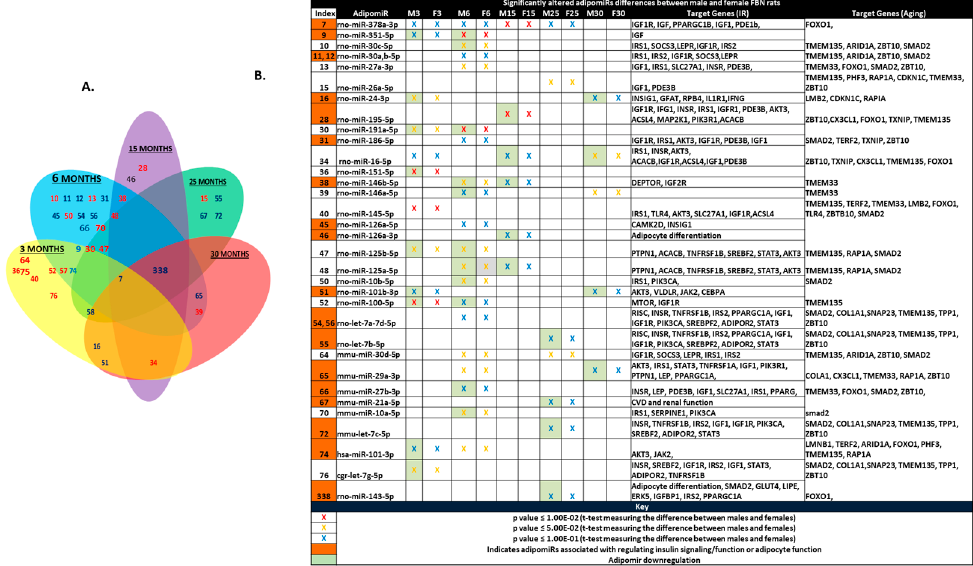
Figure 3. Di ff erential expression of adipomiRs between the two sexes: ( A ) Lotus scheme depicting the di ff erentially expressed adipomiRs in every age group between males and females. Each number in the lotus diagram represents an individual adipomiR whose ID is listed in the accompanying table. Each petal of the lotus scheme shows the adipomiRs that are commonly significantly altered in each group between the two ages. ( B ) Tabular representation of the di ff erentially expressed miRNAs. Targetscan 7.2 was used to identify targets involved in pathways related to insulin resistance and the aging pathway. Orange shaded numbers in the Table represents adipomiRs associated with regulating insulin signaling and / or adipocyte function. Red X— p -value ≤ 1.00 × 10 − 2 ; orange X— p -value ≤ 5.00 × 10 − 2 and blue X— p -value ≤ 1.00 × 10 − 1 ( t -test measuring the di ff erence between males and